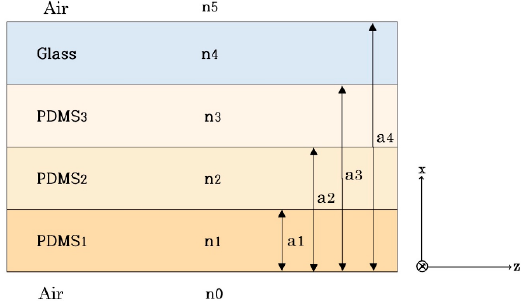
Figure 8. Structure of the proposed multilayer optical waveguide.